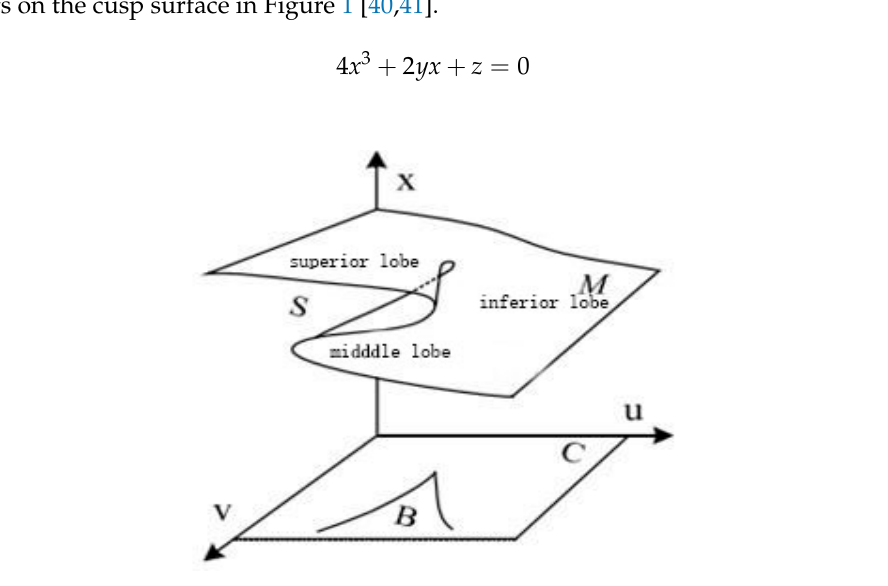
Figure 1. Cusp catastrophe equilibrium surface.